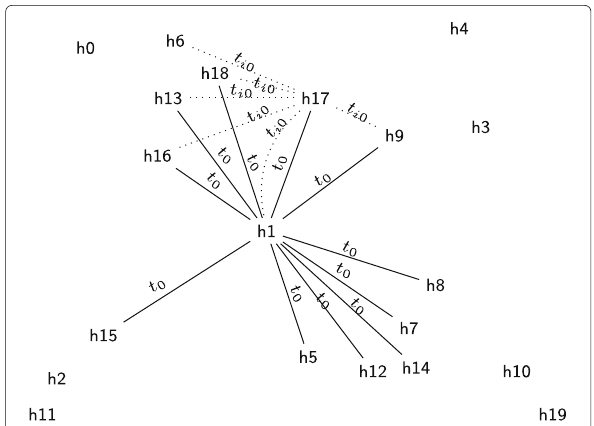
Fig. 17 Convergence of data message propagation and inhibition in proposed endcast